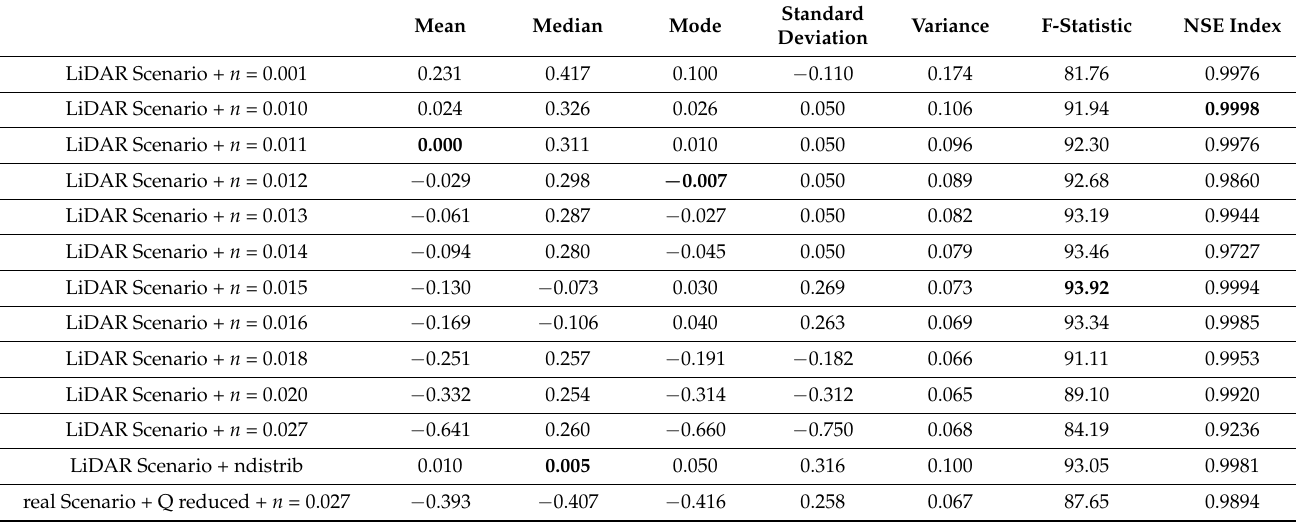
Table 1. Statistical data about Manning’s n value calibration process, considering both hydrodynamic outputs, namely, flow depth and flooding